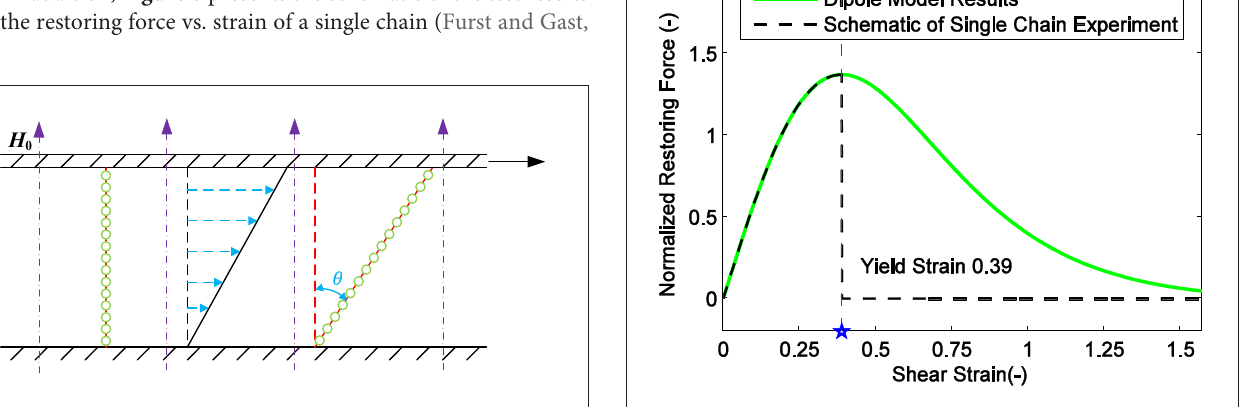
FIGURE 6 | Response of the normalized restoring force vs. shear strain for a single chain of MR